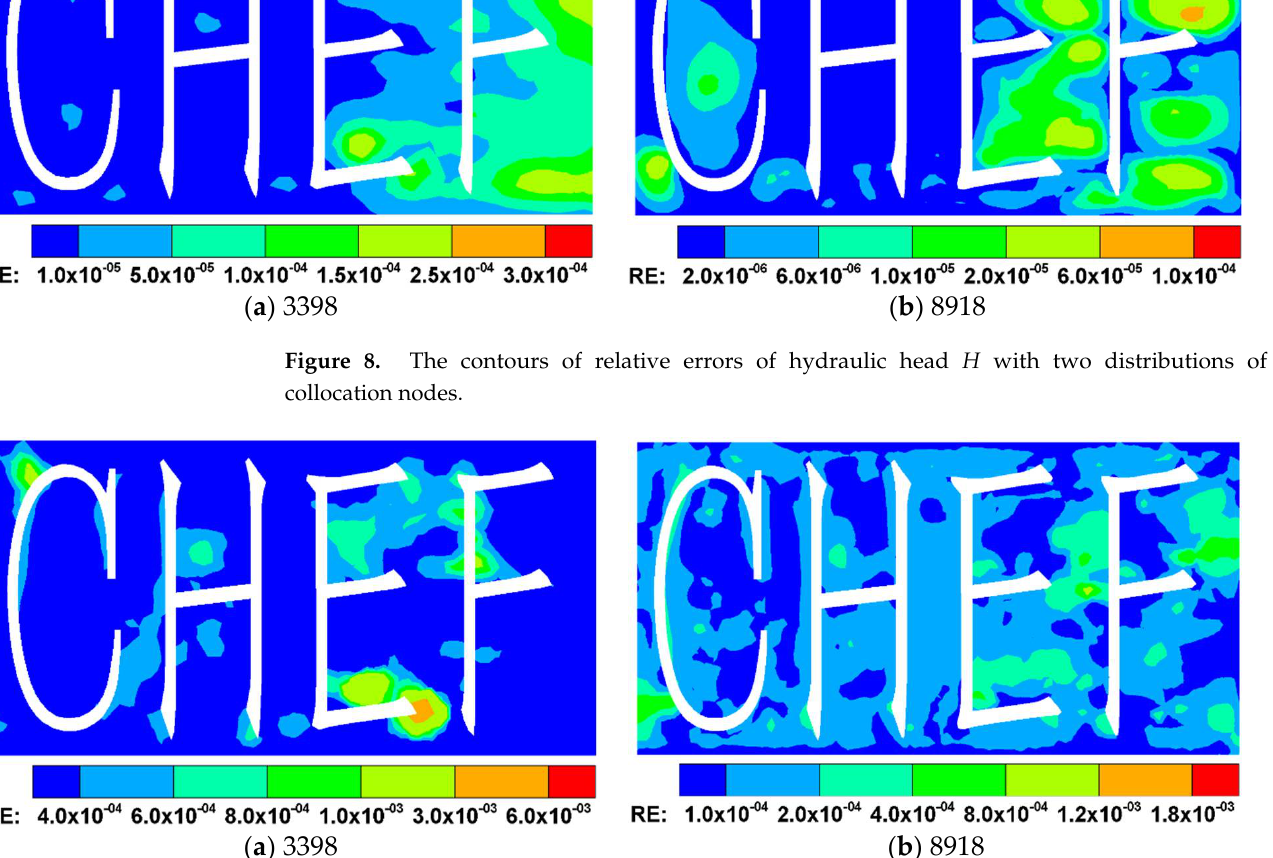
Figure 9. Relative error distributions of flux ∂ H / ∂ x with different number of collocation